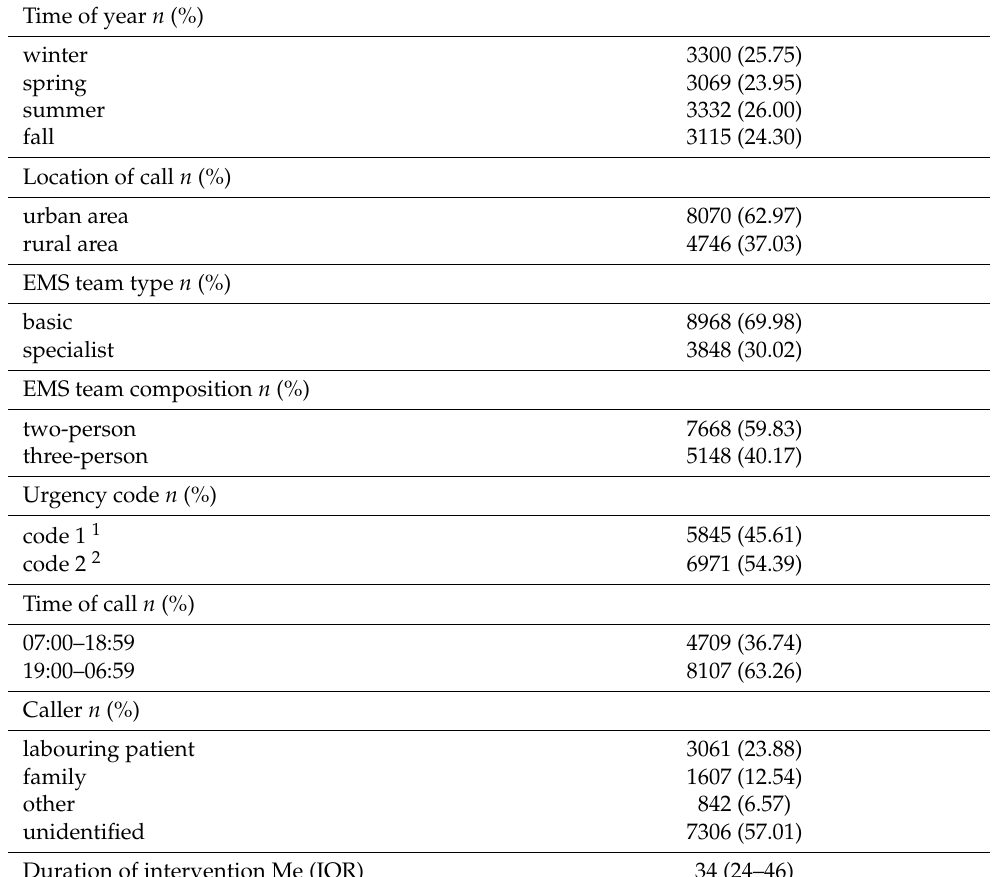
Table 2. Characteristics of EMS (Emergency Medical Services) team responses to calls regarding suspected labour.